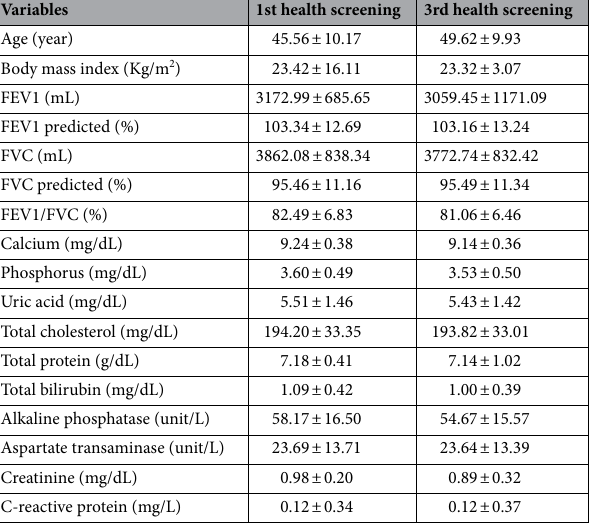
Table 1. General characteristics and laboratory parameters of the enrolled individuals at the first and third health screenings. Data present presented as mean ± standard deviation.